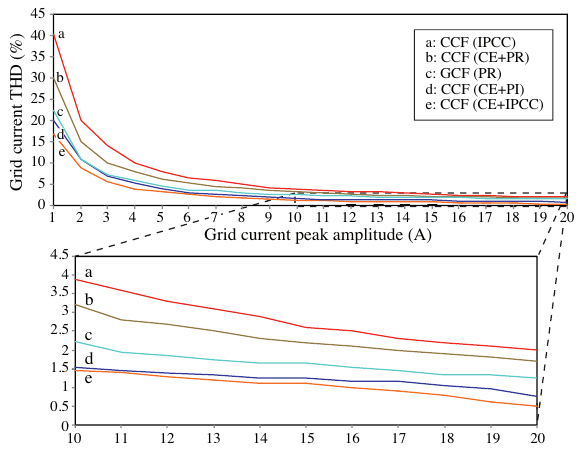
Figure 15. Grid current THD for different CCF (with and without the CE technique) and GCF strategies.